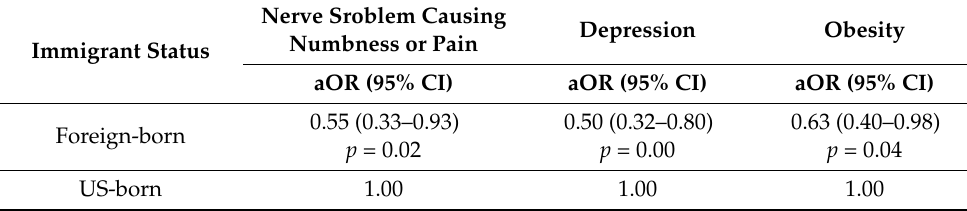
Table 3. Associations between immigrant status and specific health